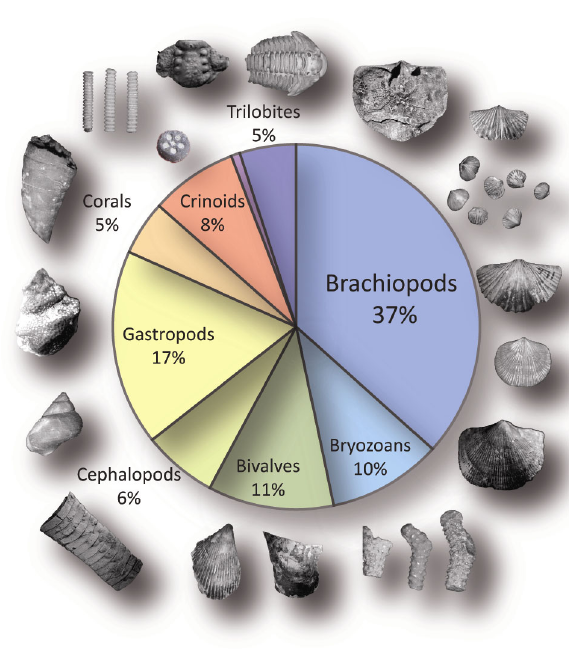
Fig. 1. Taxonomic distribution of fossils within the Ohio University Kallmeyer collection. The unlabeled pie slice represents specimens of other taxonomic affinities.